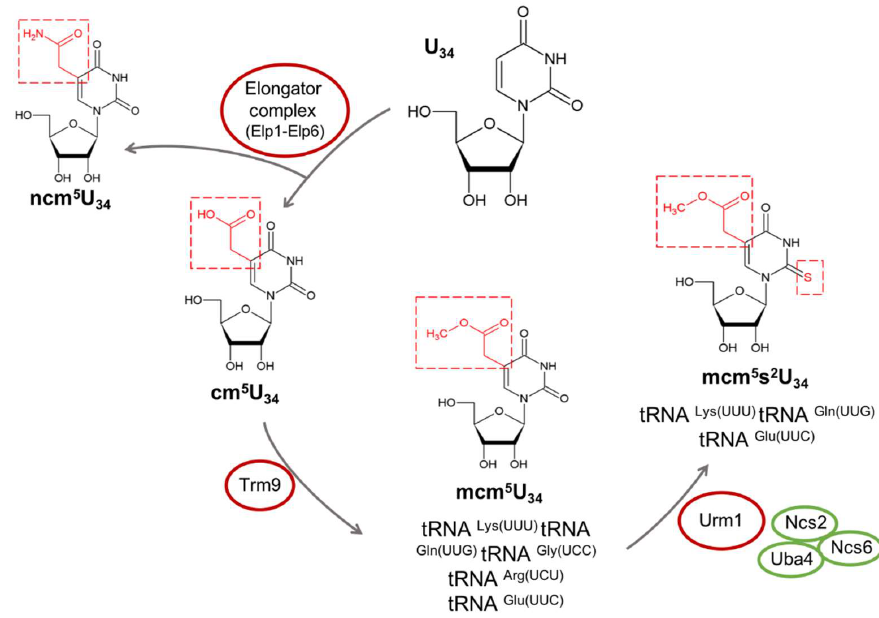
Figure 2. Yeast biosynthesis pathways of modified wobble uridines in different tRNA substrates catalyzed by the Elongator complex (Elp1–Elp6), Trm9, and Urm1 enzymes and the ubiquitin-ligase-like proteins, namely, Uba4, Ncs2, and Ncs6. In yeast, the Elongator complex (Elp1–Elp6) catalyze the wobble uridine (U 34 ) modifications that form 5-carbamoylmethyluridine (ncm 5 U 34 ) and 5-carboxymethyluridine (cm 5 U 34 ). Then, the methyltransferase Trm9 uses cm 5 U 34 as a substrate in different tRNAs: tRNA Lys(UUU) tRNA Gln(UUG) , tRNA Gly(UCC) , tRNA Arg(UCU) , and tRNA Glu(UUC) . Subsequent addition of a 2-thiol group by an enzyme cascade involving Urm1 and Uba4, Ncs2, and Ncs6 occurs in three of these tRNAs: (tRNA Lys(UUU) , tRNA Gln(UUG) , and tRNA Glu(UUC) ). All modified nucleosides presented in this figure can be found in the MODOMICS database. Red dashed boxes represent the modification catalyzed by the respective enzymes in each step. Abbreviations: tRNA, transfer RNA; ncm 5 U, 5-carbamoylmethyluridine; cm 5 U, 5-carboxymethyluridine; mcm 5 U, 5-methoxycarbonylmethyluridine; mcm 5 s 2 U, 5-methoxycarbonylmethyl-2-thiouridine.